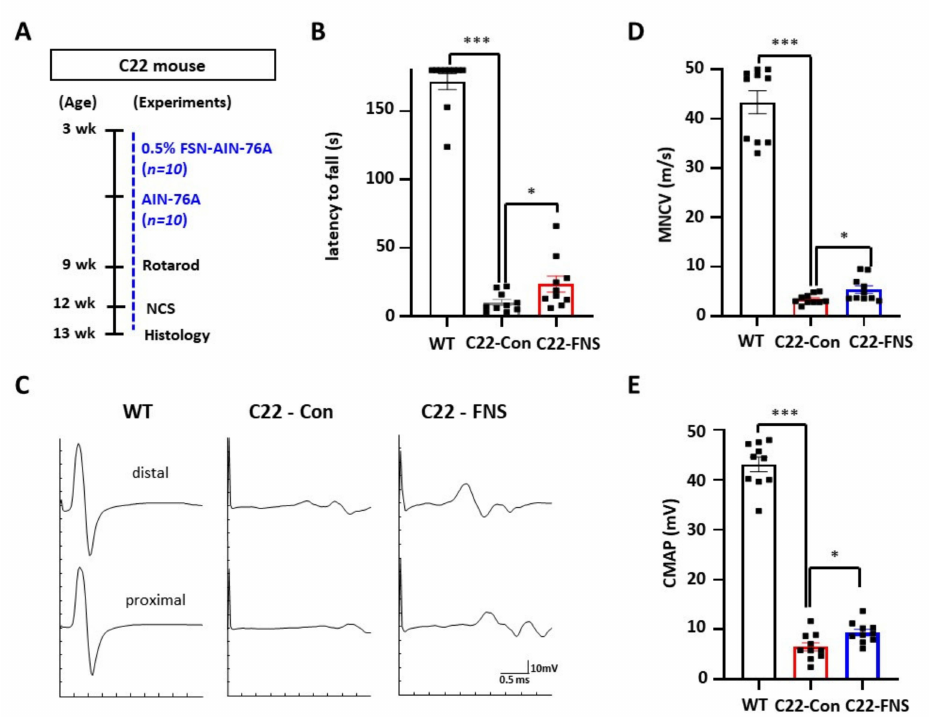
Figure 3. Behavioral and electrophysiological enhancements in farnesol-administered mice. ( A ) Experimental scheme of farnesol administration to C22 mice. C22 mice were fed AIN-76A diet containing 0.5% ( w / w ) farnesol (C22-FSN, n = 10) or AIN-76A diet (C22-Con, n = 10) from 3 weeks of age. Age-matched wild-type mice ( n = 10) were used as a reference ( B ) Rotarod test was performed to evaluate locomotor function. ( C ) Representative images of electrophysiological evaluation. ( D ) motor nerve conduction velocity (MNCV). ( E ) Compound muscle action potential (CMAP). WT, wild-type mice; C22-Con, control diet fed C22 mice; C22-FNS, farnesol diet fed C22 mice; * p < 0.05; and ***, p < 0.001.